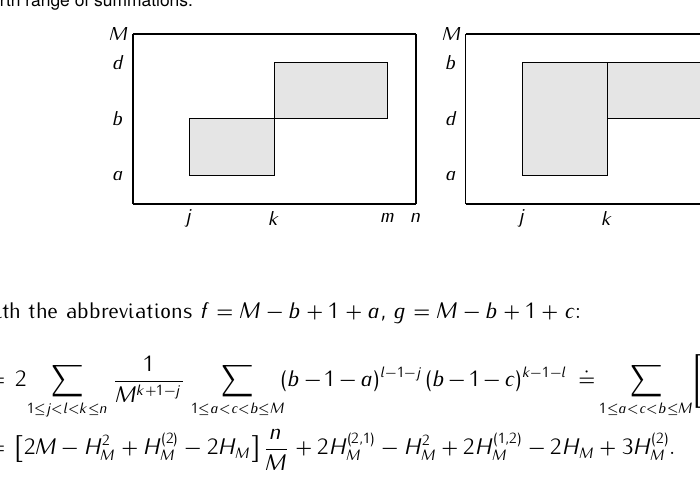
Figure 2. Fourth range of